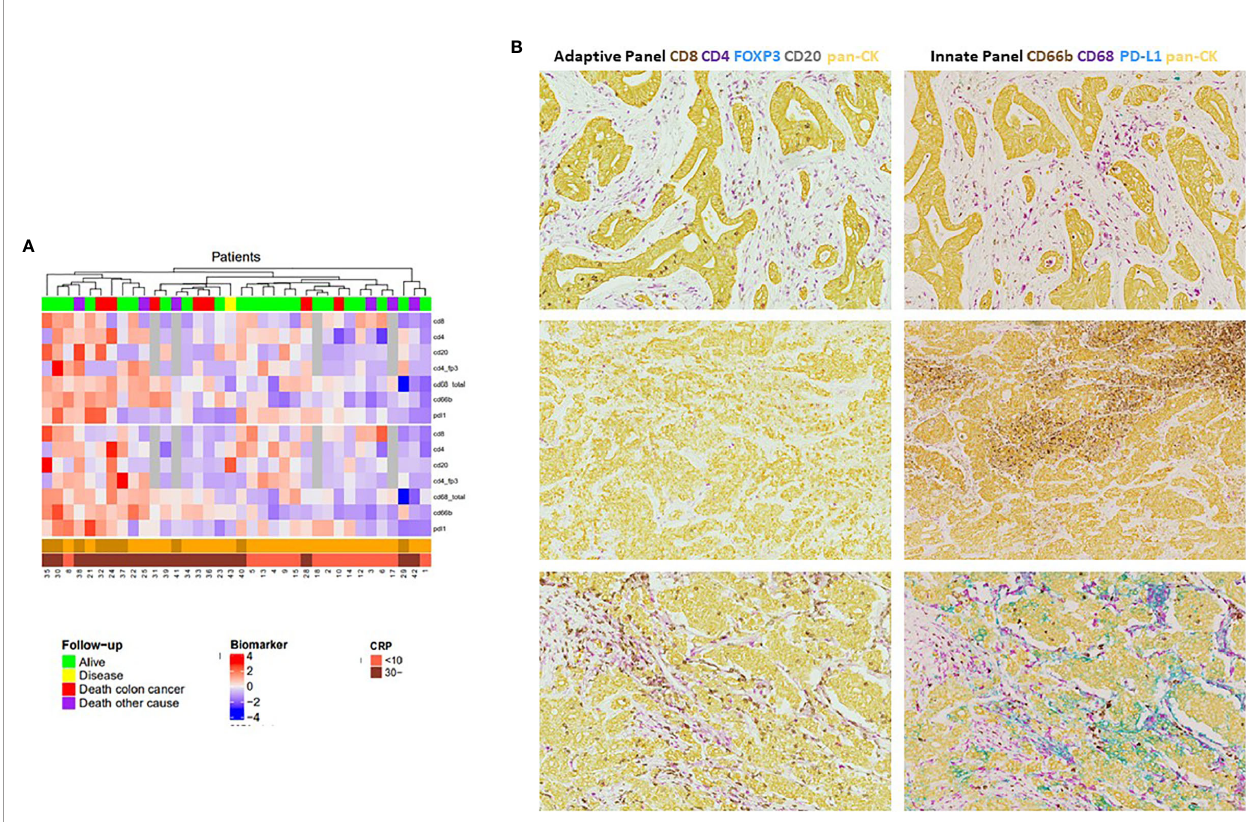
FIGURE 6 | Hierarchical cluster analysis of selected adaptive and innate immune markers in primary resected colon cancer patients. Heat map of unsupervised hierarchical clustering based upon the densities of tumor-in fi ltrating immune markers. Data were log-transformed to get a normal distribution, standardized to mean zero and variance 1. Information on CRP values; MSI and follow-up statuses were added to the dendrogram for visual interpretation after performing the cluster analysis. (A) Clustering based upon tumor-in fi ltrating immune cell densities and PD-L1 tumor expression. Red color indicates high density, blue low density of each immune marker. (B) Representative images from patients with the three predominant immune phenotypes present within our cohort. Upper panel: mIHC-stained tumor slides from a CRP low, MSS pt. with prominent lymphoid in fi ltration and modest myeloid immune in fi ltration. Middle panel: tumor slides from a CRP-high, MSS pt. showing predominant myeloid in fi ltration (almost exclusively CD66b+ neutrophils) and only marginal in fi ltration by lymphoid immune cells (CD4+ T cells only). Lower panel: tumor slides from a CRP-high, MSI-positive pt. being hyperin fl amed with vigorous lymphoid and myeloid immune in fi ltration and high PD-L1 expression, predominantly expressed by CD68+